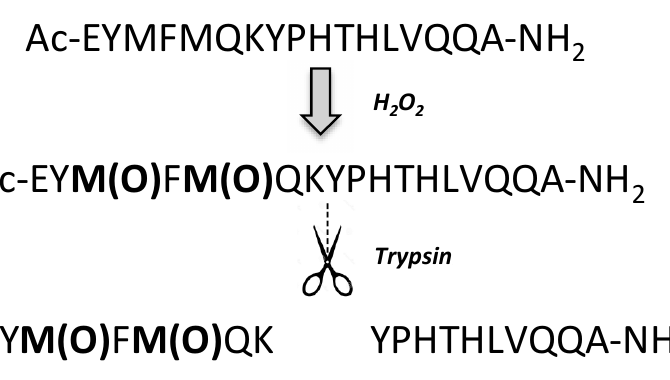
Figure 1. Scheme of the hydrolysis of GDF11[48-64]ox by trypsin and identification of the oxidation sites on methionines.